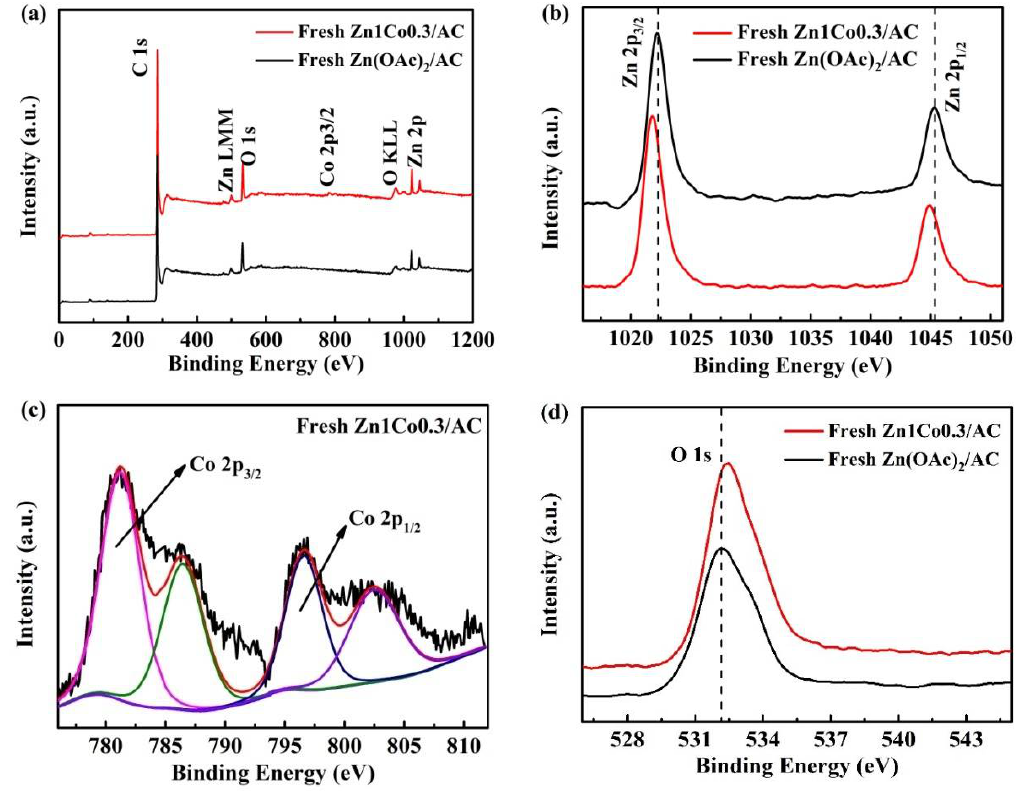
Figure 4. XPS spectra of fresh Zn1Co0.3/AC and Zn(OAc) 2 /AC catalysts: ( a ) wide XPS survey spectra; ( b ) XPS spectrum of the Zn 2p region; ( c ) XPS spectrum of the Co 2p region for Zn1Co0.3/AC catalyst; ( d ) XPSspectrum of theO 1s region.